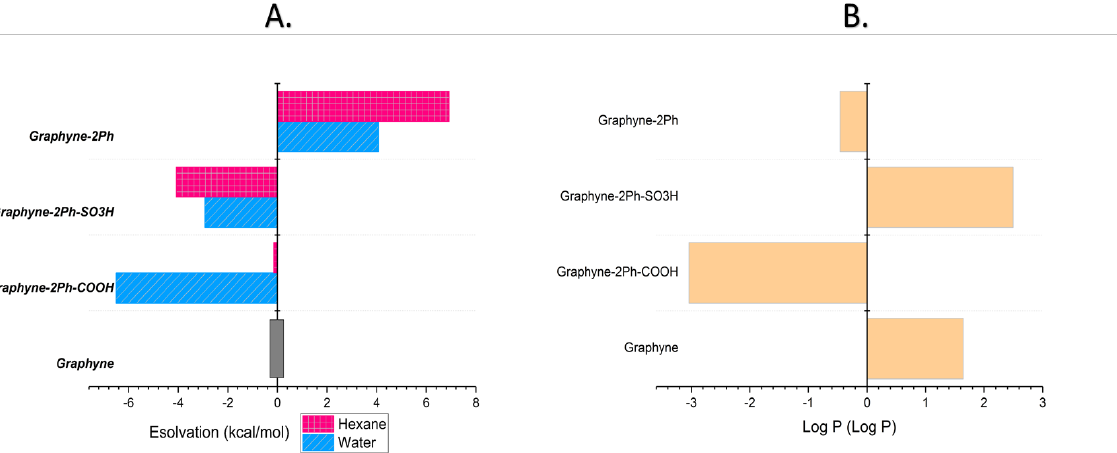
Figure 8: A. The solvation energy differences for the grafted graphyne structure (with two phenyl groups) in water and hexane. B. Calculated Log P